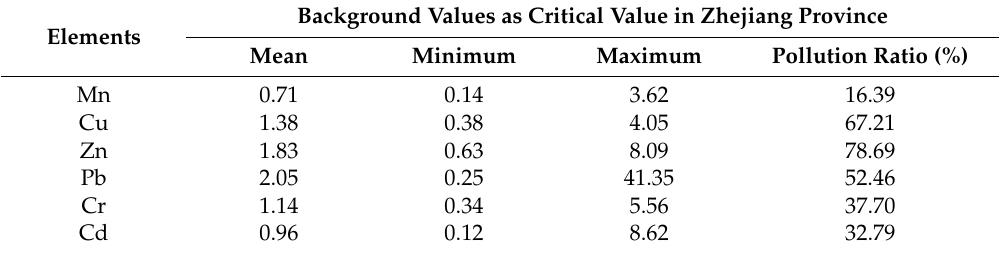
Table 2. The evaluated results of single factor pollution index for soil PHMs in Lin’an.